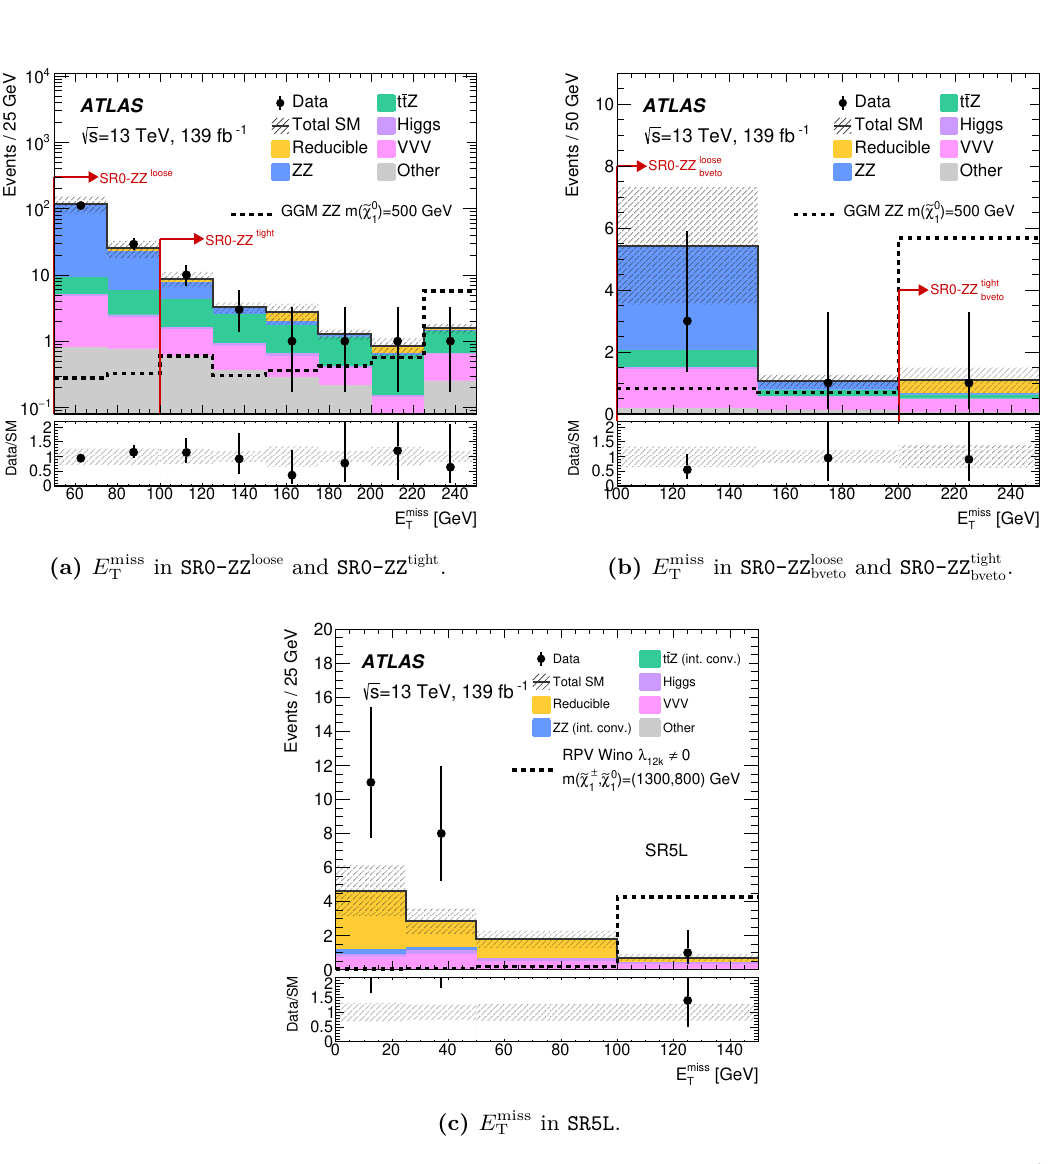
and SR0-ZZ tight , bveto bveto requirement. Dis- T